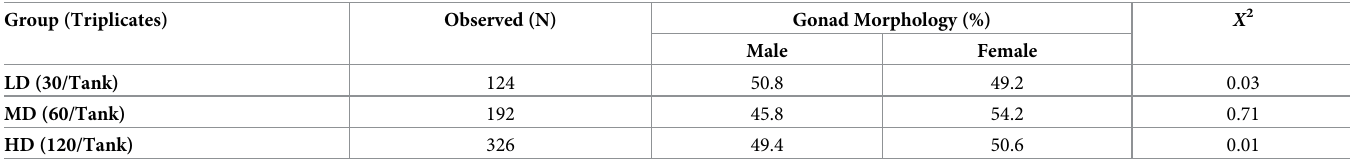
X 2 value is for comparison with an expected normal ratio of males to females of 1:1 or the ideal sex proportion of 0.5 males or females in population. There is no significant difference of all density groups when compared to the normal ratio of males to females (P >